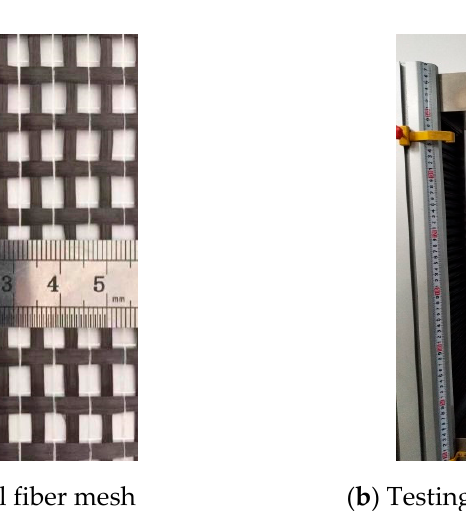
Table 4. Mechanical properties of the CFRP.